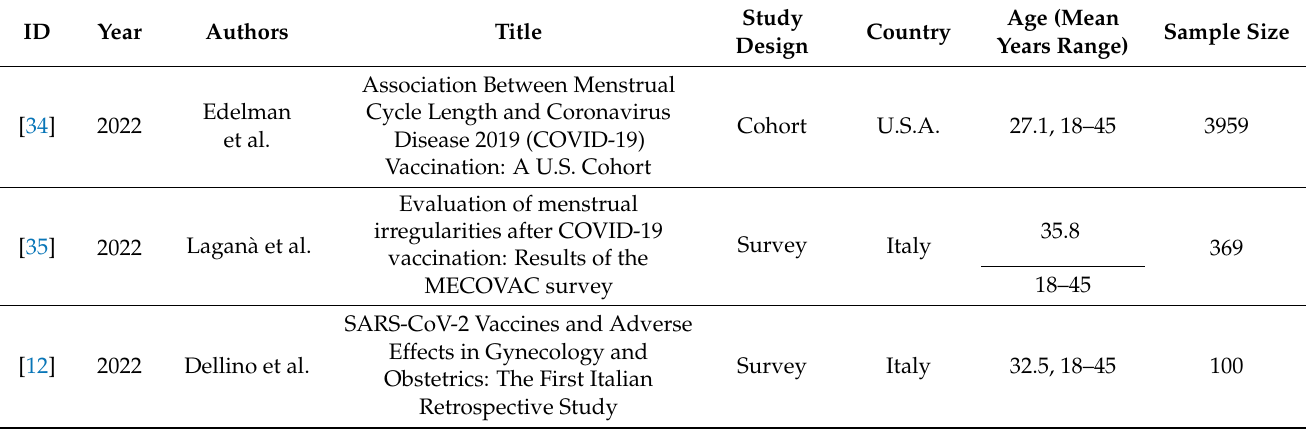
Table 2. Studies that report the characteristics of the menstrual cycle in relation to the COVID- 19